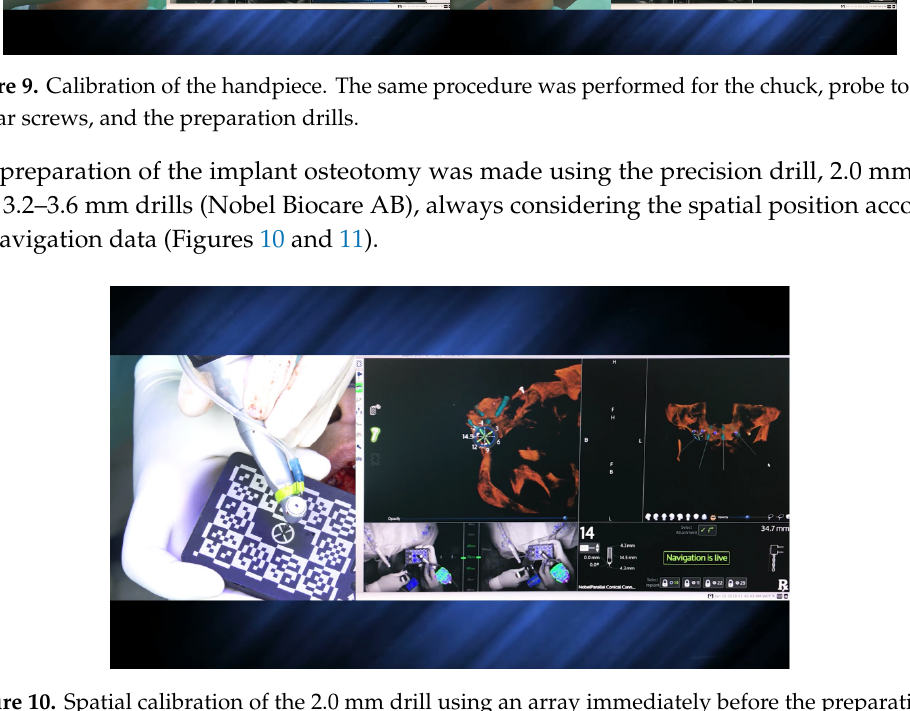
Figure 11. Perioperative preparation of the posterior implant (placed in a tilted position) with the 2.0 mm drill using live navigation. Note the data on the right-hand side considering depth and angle. The X-Guide system (X-Nav Technologies) tracked the patient and surgical instruments and presented the real-time position and guidance feedback on a computer display for every step of the surgery (Figures 12 and 13). Thus, the accurate and precise implant placement, in terms of depth (14.4 mm) and angulation (0.7 degrees), led to the most favorable surgical and prosthetic positions (Figure 13). This way, it was possible to avoid important anatomic structures, such as the maxillary sinus and nasal cavities. Four NobelParallel CC implants (Nobel Biocare AB) were placed following the All-on- 4 concept: 4.3 mm × 15 mm implants placed posteriorly and 3.75 mm × 15 mm implants placed anteriorly and all implants had insertion torques greater than 35 N/cm.